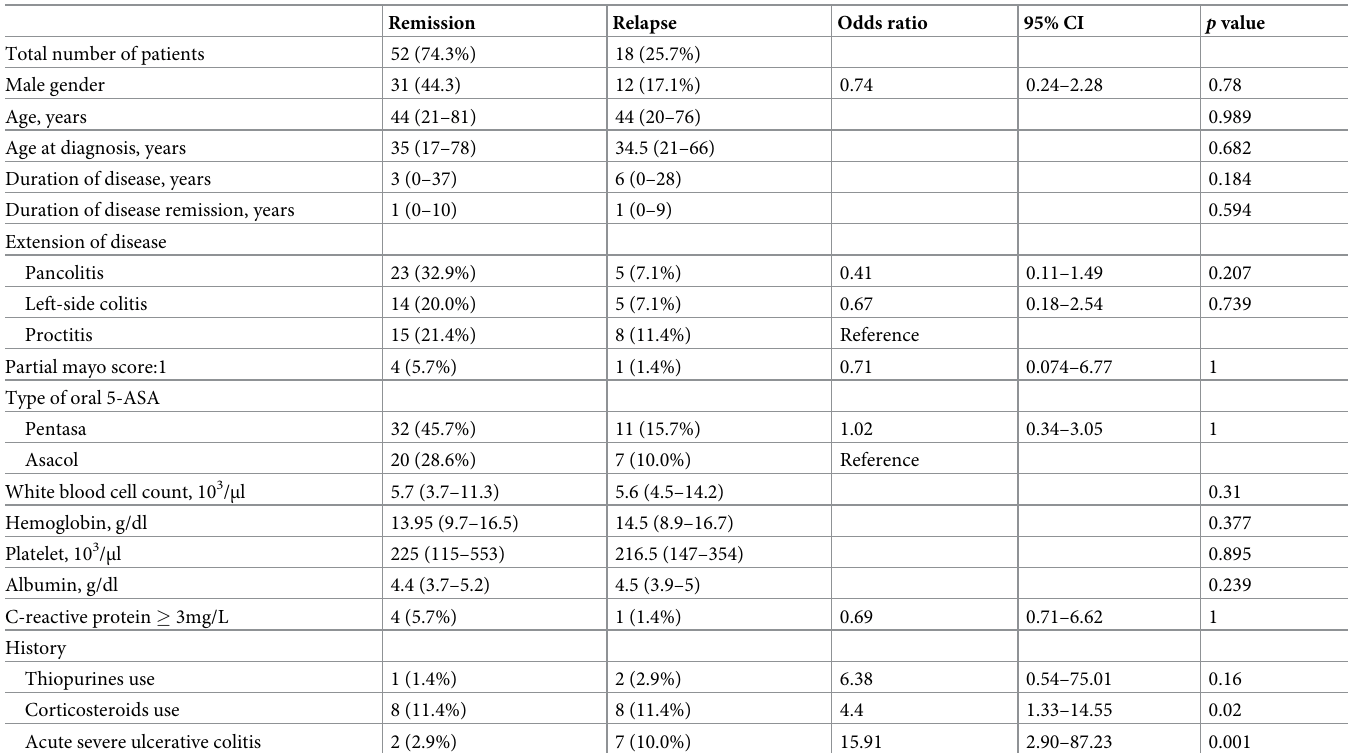
Table 2. Univariate comparison between the patients who relapsed and those who maintained remission.